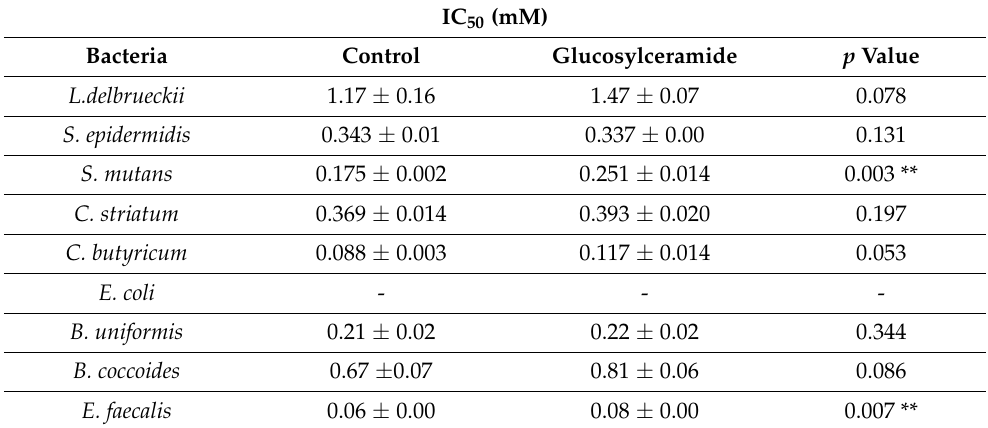
Table 3. IC 50 of bacteria towards deoxycholic acid with or without glucosylceramide